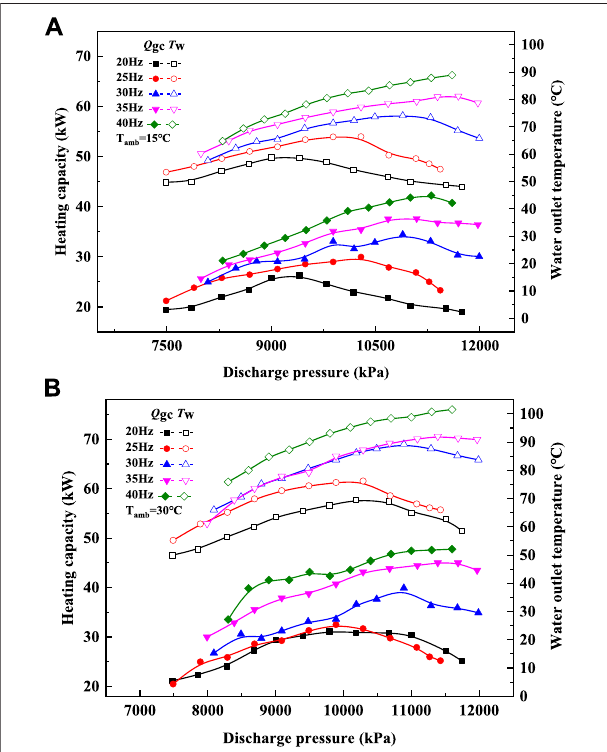
FIGURE 8 | Corresponding heating capacity and the GCW under different discharge pressures. (A) Ambient temperature of 15 ° C. (B) Ambient temperature of 30 °